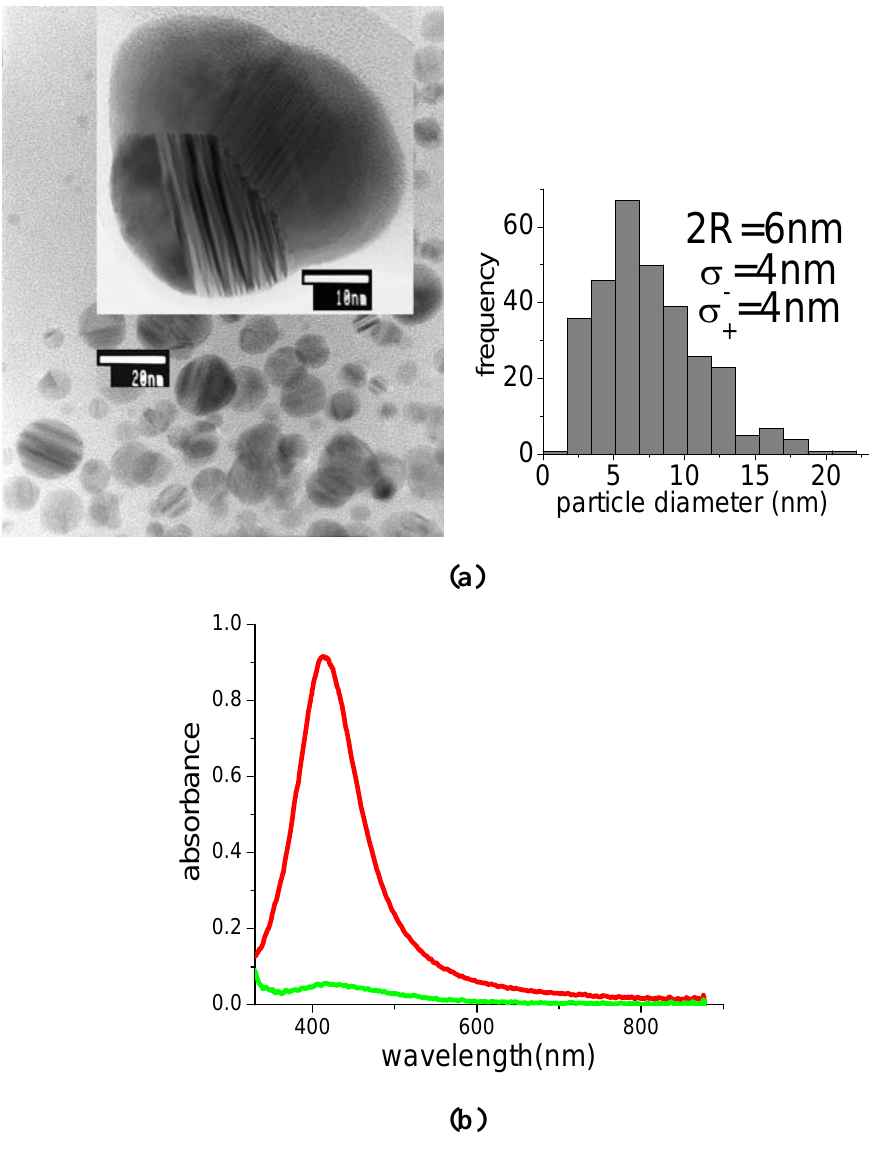
Figure 9. (a) TEM image and statistical distribution of particle size for a suspension of PAMAM G5-capped AgNPs produced with 1,064 nm and 15 mJ pulses. (b) UV-Vis spectra of the same suspension before (red curve) and after (green curve) post-irradiation with 532 nm, 8 mJ, 30,000